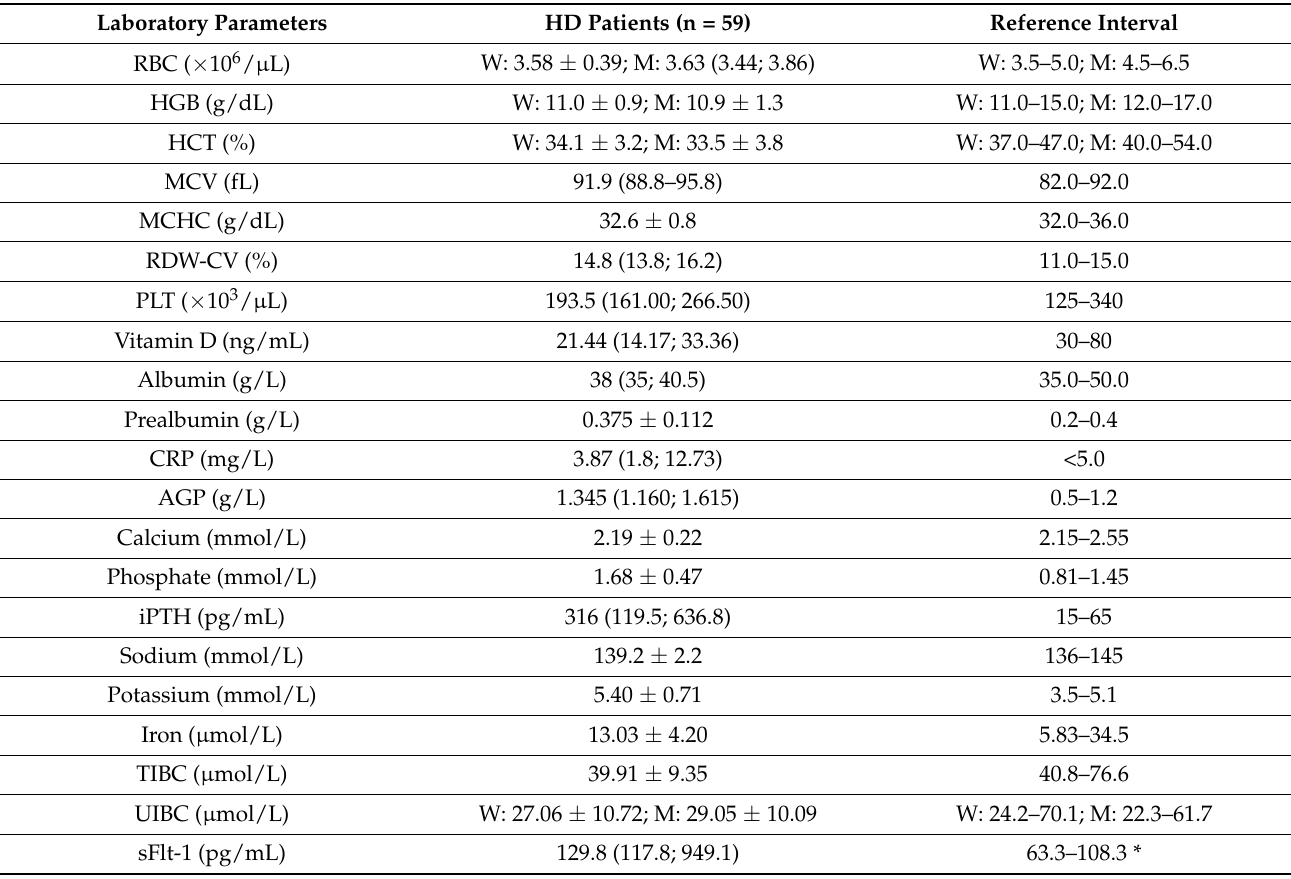
Table 2. The results of selected laboratory tests in the studied group of ESRD patients. Data are shown as arithmetic means of the results obtained in post-summer and post-winter assessment.